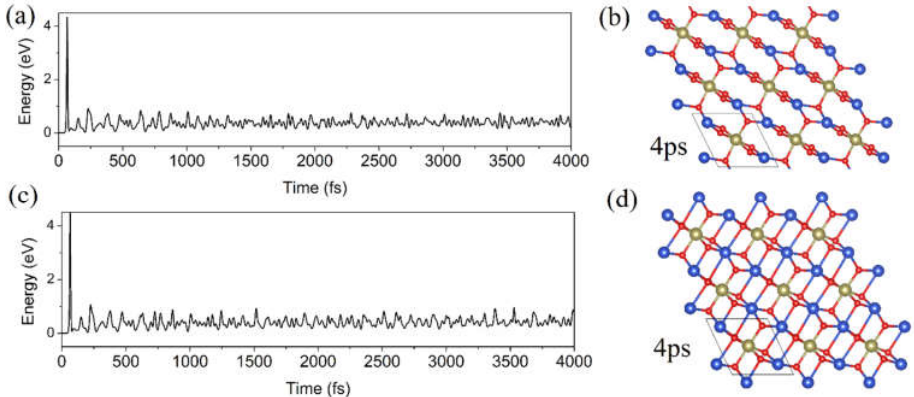
Figure 2. Total energy fluctuation obtained from AIMD simulations conducted at 300 K ( a ) and 320 K ( c ) for the time of 4 ps for the Cu 2 TeO 6 monolayer. The atomic structure of the Cu 2 TeO 6 monolayer at 300 K ( b ) and 320 K ( d ) after 4 ps.